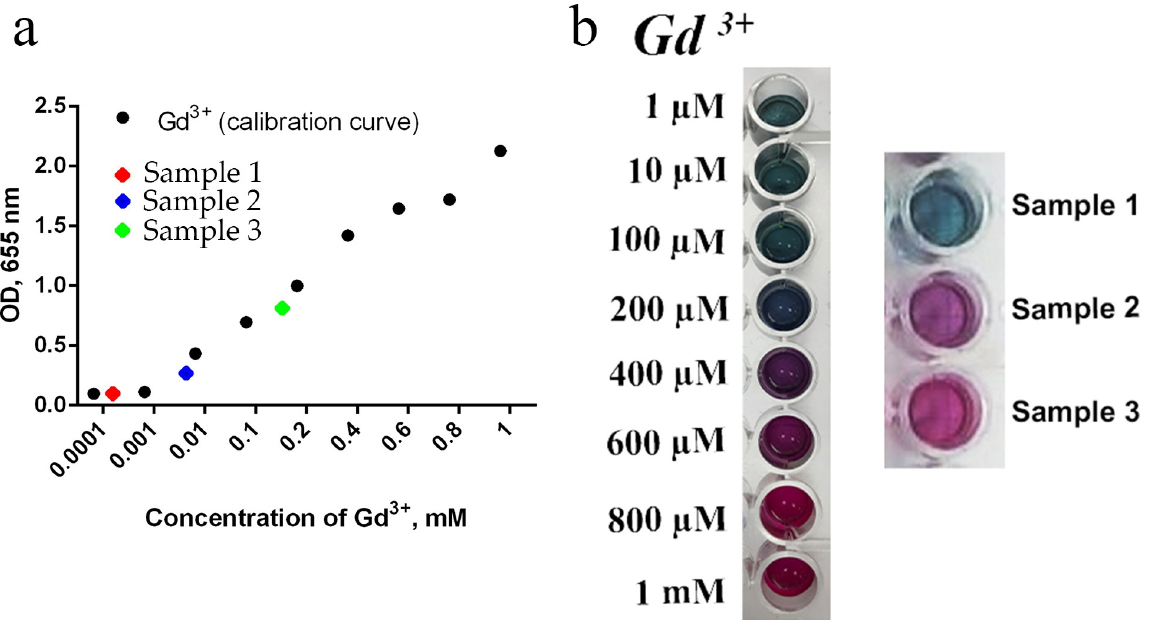
Figure 11. Analysis of free gadolinium content in saline after incubation with Ce 0.8 Gd 0.2 O 2 − x nanoparticles. ( a ) Optical density (OD) values at 655 nm of the controls (black dots) and of the colloid solution of Ce 0.9 Gd 0.1 O 1.95 NPs mixed with arsenazo III (red, blue and green dots). ( b ) The appearance of gadolinium(III) nitrate aqueous solutions of various concentrations (0.001–1.000 mM) mixed with arsenazo III, used as controls for the construction of the calibration curve.